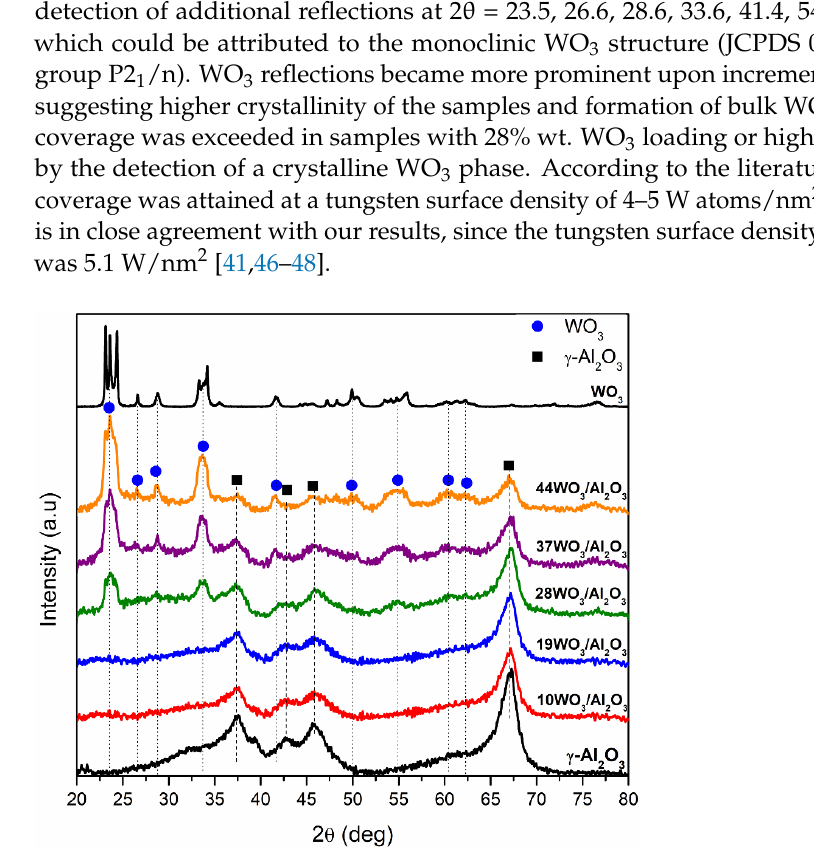
Figure 2. X-ray diffractograms of WO 3 /γ -Al 2 O 3 catalysts. Raman spectra of the supported catalysts recorded under ambient conditions are presented in Figure 3. The pure WO 3 Raman spectrum w included for comparison. The only bands detected are associated with tungsten species, whereas there are no additional Raman vibrations attributed to γ -Al 2 O 3 . All tungsten-containing samples exhibit a charac- teristic band in the region 975–986 cm − 1 , which is assigned to the symmetrical stretching mode (W = O) of tetrahedral monotungstate species. An increase in the intensity of this band was observed upon an increase in tungsten surface coverage, along with a systematic shift of its position from 975 (10% wt. WO 3 ) to 986 cm − 1 (37 and 44% wt. WO 3 ) due to the polymerization of the amorphous monotungstates to distorted octahedral polytungstates, leading to less hydrated tungsten species on the catalyst surface [39,48]. Apart from the mono- and polytungstate species, crystalline WO 3 was also detected in the catalysts with higher tungsten loading ( ≥ 28% wt.), demonstrated by the appearance of additional bands at 275, 716 and 810 cm − 1 attributed to the W–O–W deformation mode and W–O bending and stretching modes, respectively [49–51]. The higher the tungsten content, the sharper the bands, indicating the increase in the crystallinity of the samples. Many research groups have reported on the nature of tungsten species formed on Al 2 O 3 support with the pro- gressive increment of tungsten surface density. There is a consensus that at low surface coverage (<5 W/nm 2 ), tetrahedrally coordinated WO 42- species coexist with octahedrally coordinated polymeric ones, being amorphous or finely dispersed on the support. Poly- tungstates dominate when monolayer coverage is achieved, whereas above